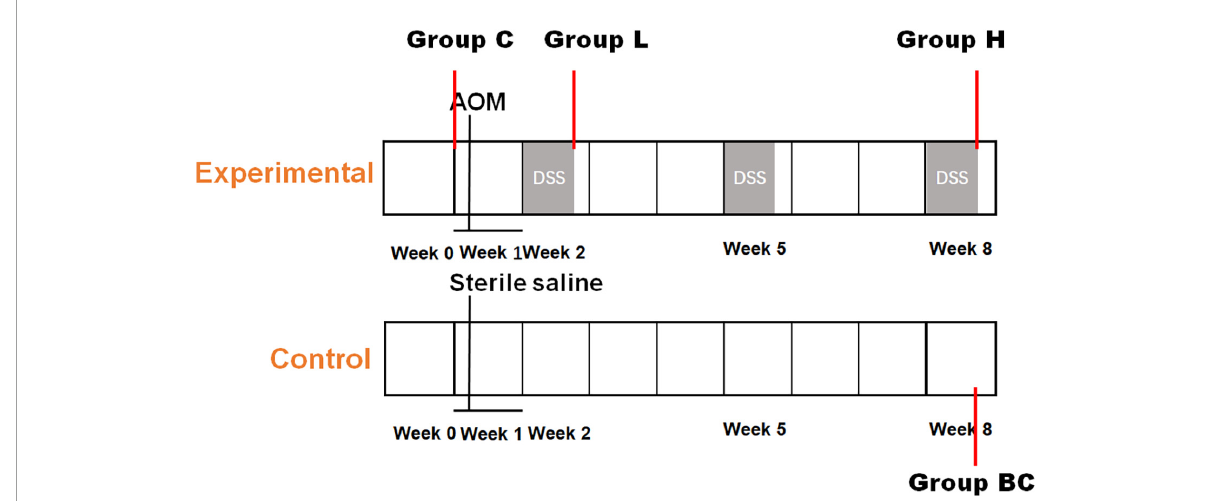
FIGURE1 Establishment of mouse colorectal cancer model. Timeline of chemical dosage in control (bottom) and experimental (top) mice.